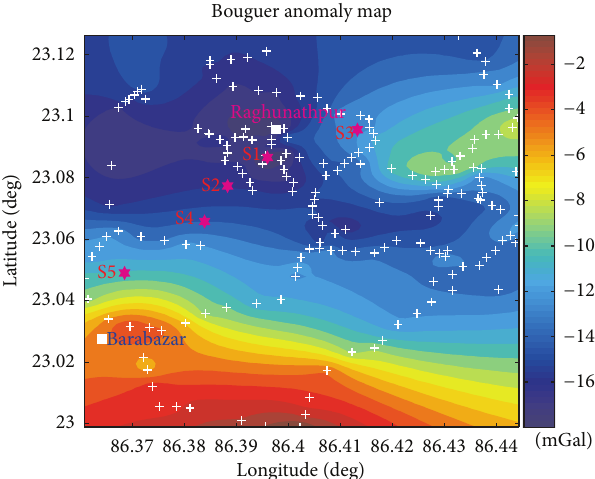
Figure 2: Bouguer anomaly map of the study area. Plus (+) symbols are the gravity survey locations.